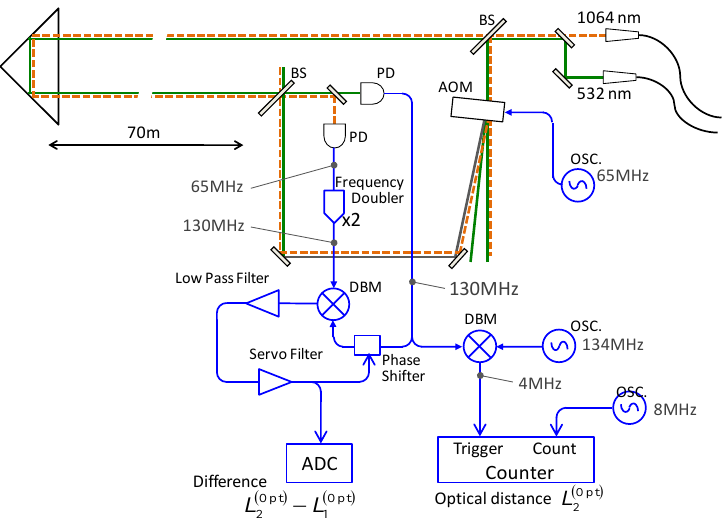
Figure 1. Diagram of the optical layout and the electrical signal processing. All oscillators are synchronized by the connection of their frequency